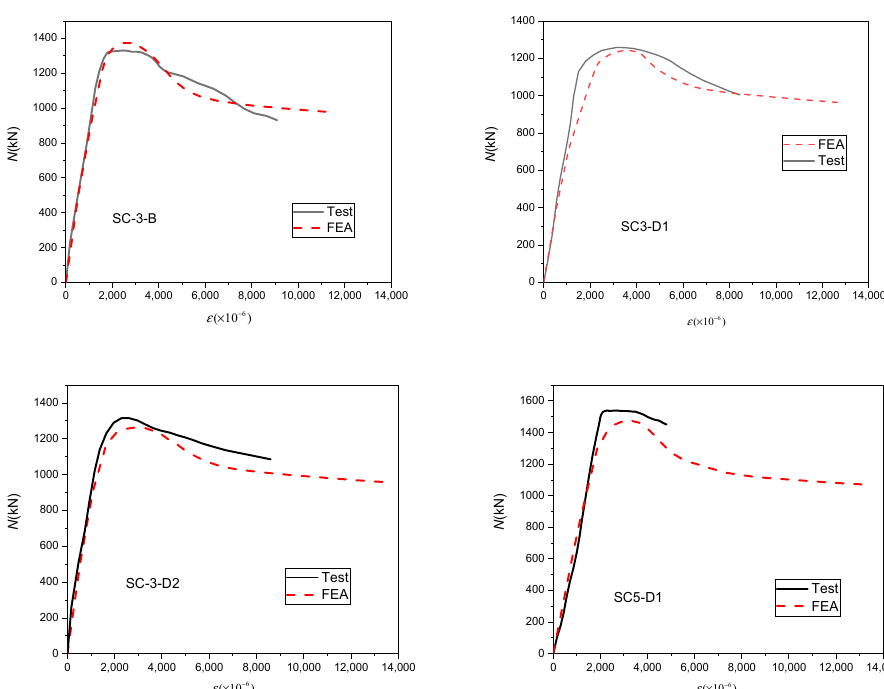
Figure 13. Comparison of typical load–strain curves of specimens.